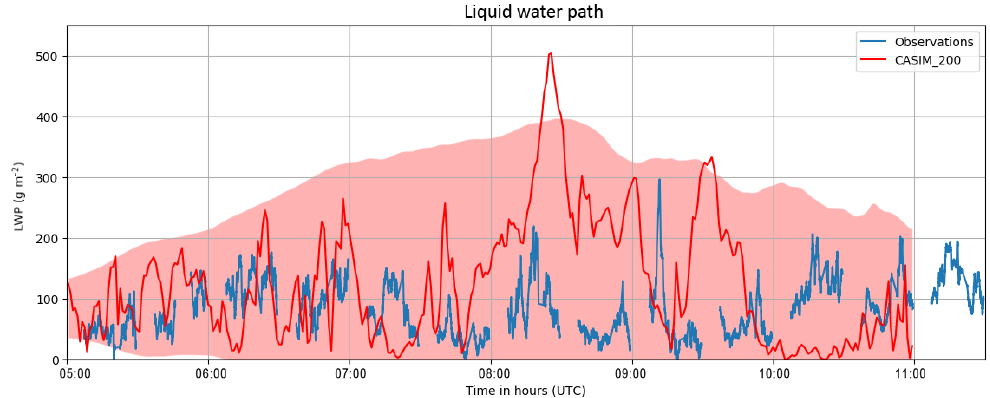
Figure 13. As in Fig. 8 but for